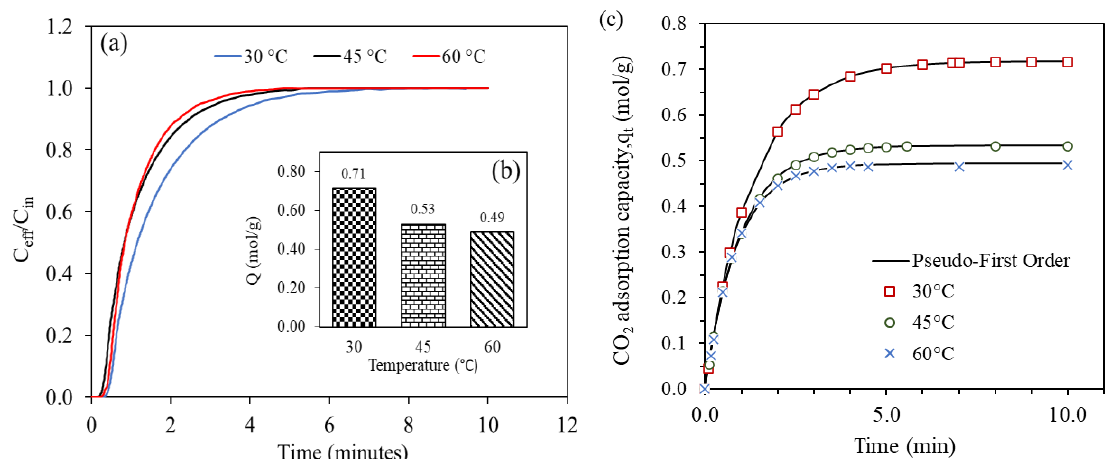
Figure 9. ( a ) Breakthrough adsorption curves, ( b ) equilibrium adsorption capacity and ( c ) pseudo- first order fitted adsorption capacity at different adsorption temperature (pressure = 2 bar, CO 2 flowrate = 60 mL/min).